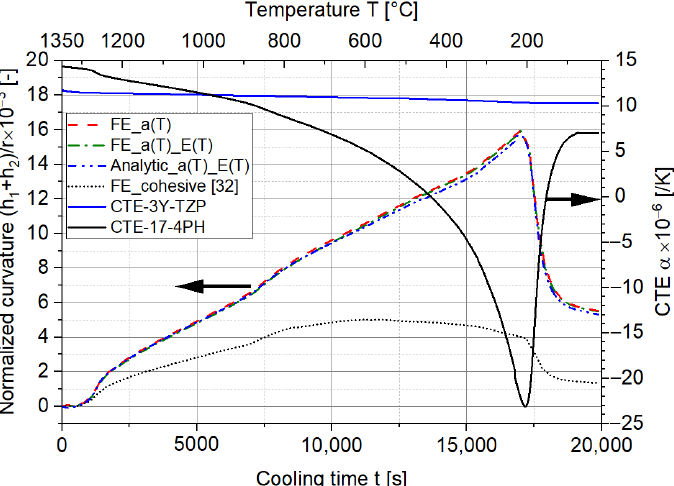
Figure 13. The influence of the temperature-dependent Young’s modulus and cohesive contact on the normalized curvature of the two-layer MCLs.